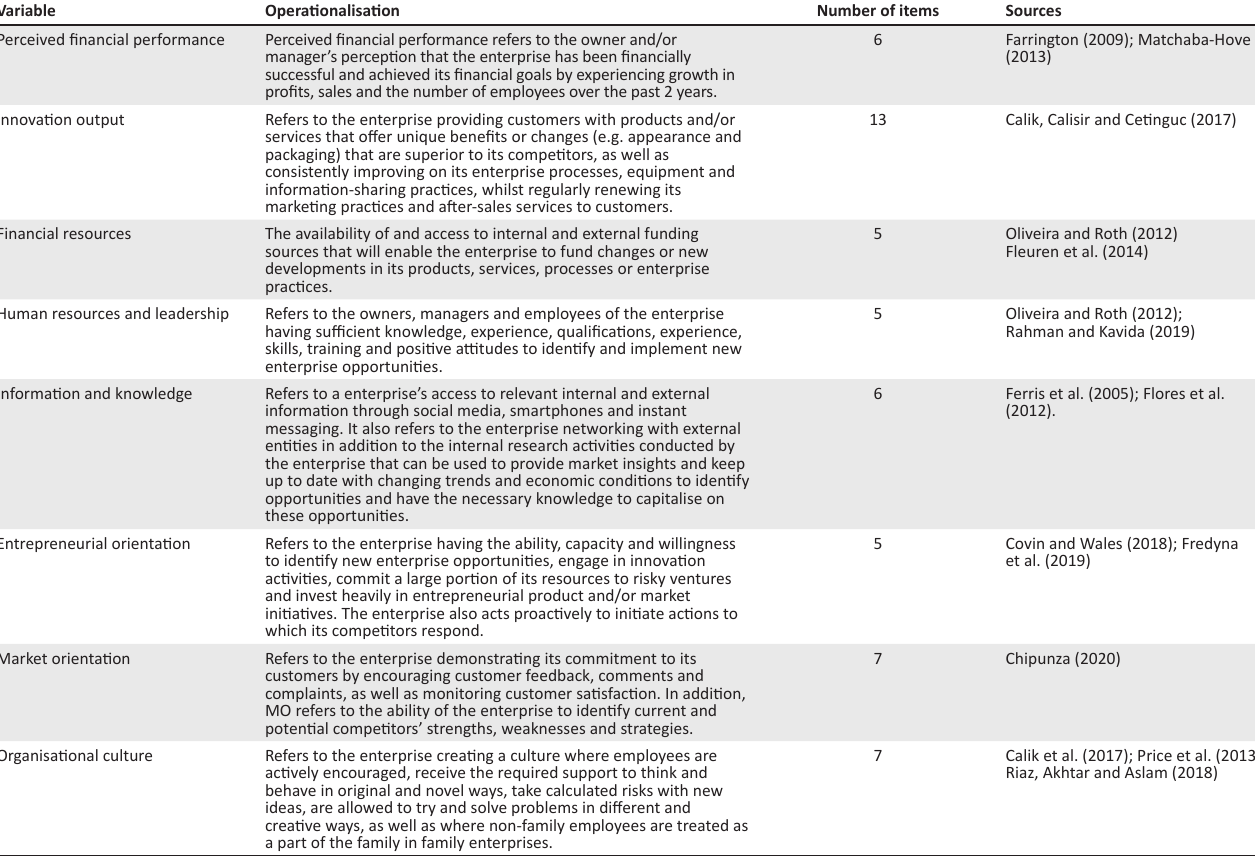
TABLE 1: Operationalisation of variables, scale items and